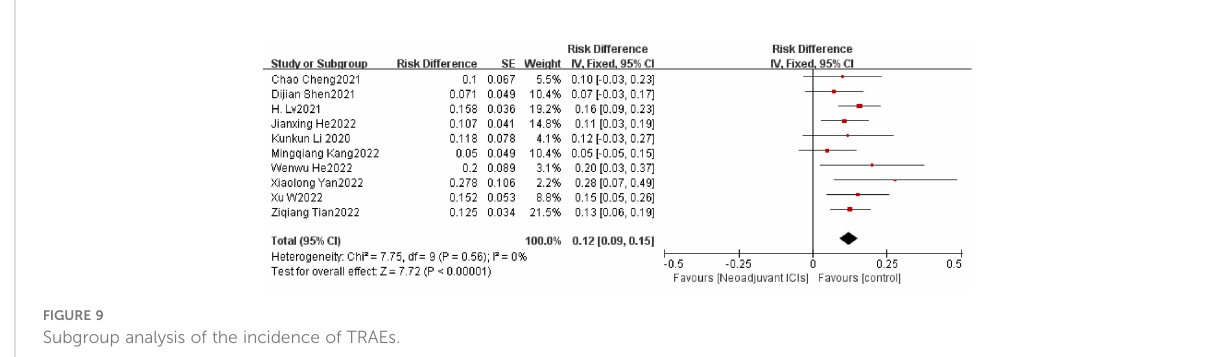
FIGURE 9 Subgroup analysis of the incidence of TRAEs.